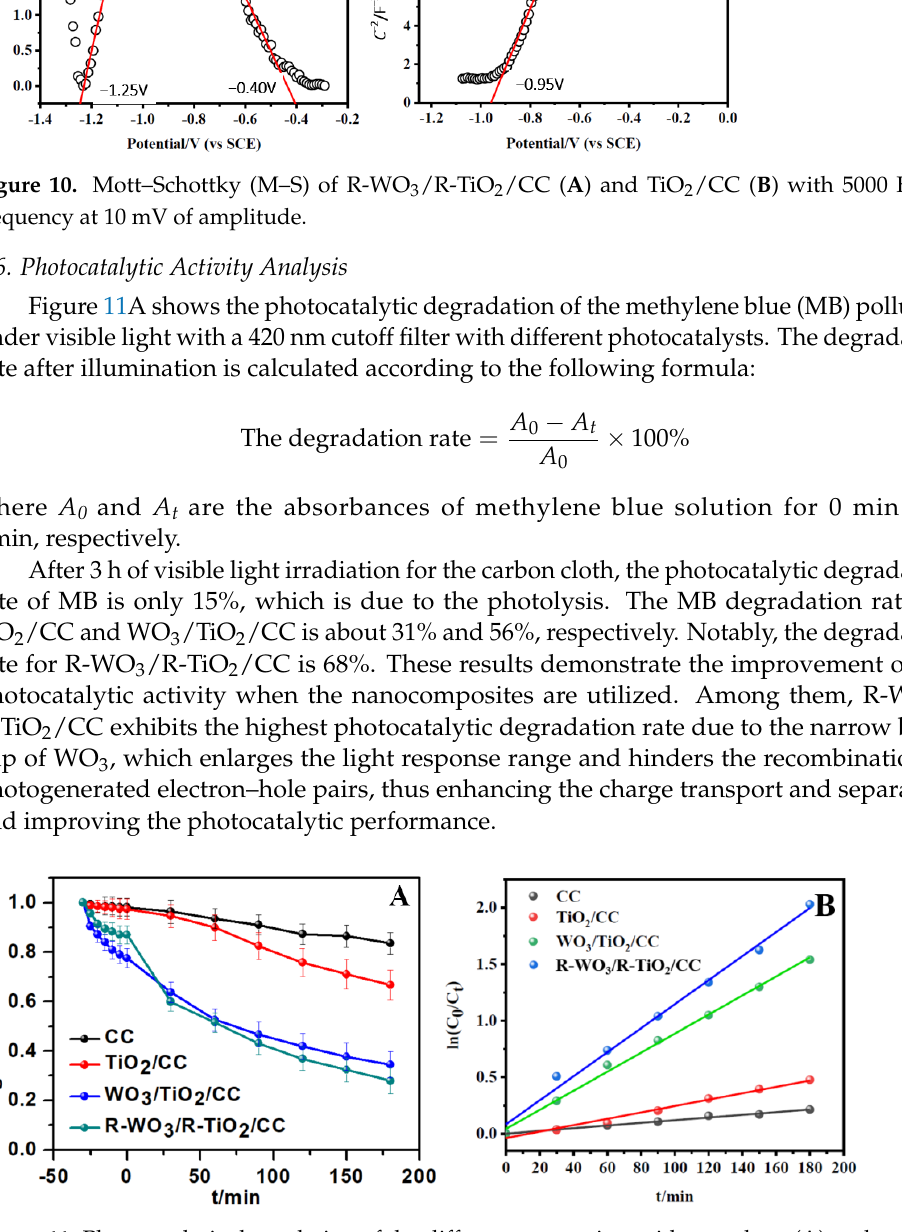
Figure 11 Figure 11. Photocatalytic degradation of the different composites with error bars ( A ) and pseudo- first-order kinetic curve ( B